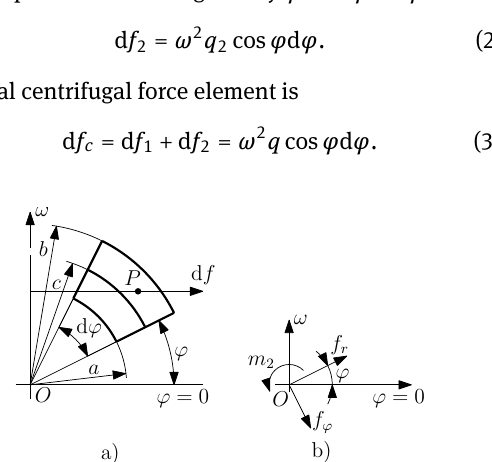
Figure 2: Determination of system of centrifugal